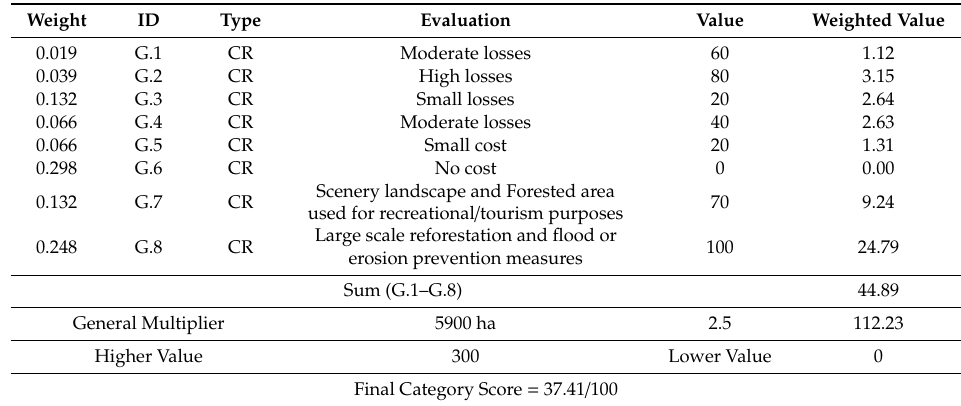
Table A20. Evaluation table of economic losses, compensation, and revenue losses from the Evros fire. CR: criterion. Original matching Table